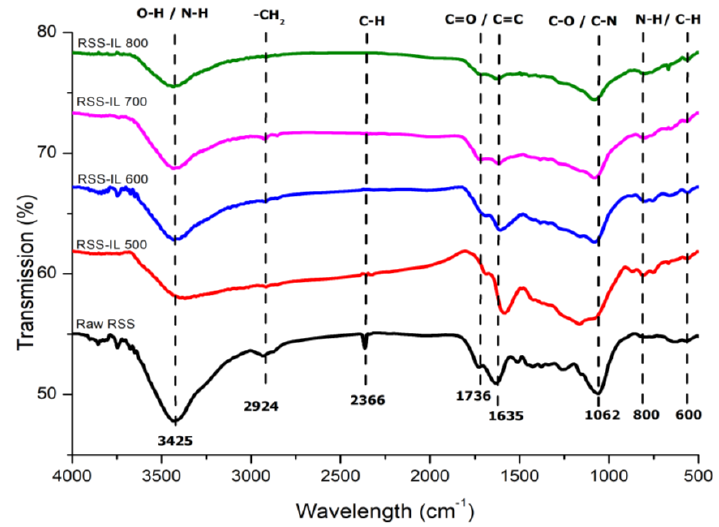
Figure 7. FTIR analysis of raw RSS and AC samples at different carbonization temperatures.